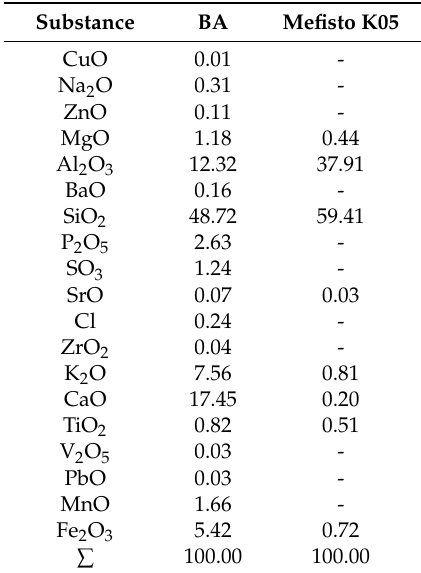
Table 4. X-Ray fluorescence analysis (XRF) chemical composition, amount